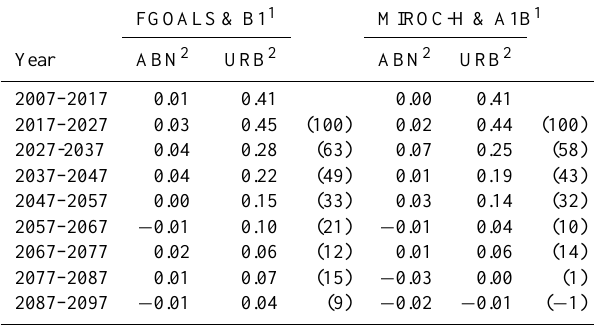
Table 2. Accounting of CO 2 removal from or emission to the at- mosphere due to soil organic carbon stock change evaluated with baseline method for a sequence of 10 periods with 10-years dura- tion in each from 2007 to 2097 under different future scenarios of climate and land-use change (unit: TgCO 2 yr − 1 ) . Numbers shown are differences in CO 2 removal from or emission to the atmosphere due to changes in size of soil organic carbon pool between BAU and MAFF-BP scenario (MAFF-BP minus BAU). Negative and positive value indicates relative CO 2 removal from or emission to the atmo- sphere due to changes in size of soil organic carbon pool in MAFF- BP scenario compared with those in BAU scenario. For land-use change scenario urbanization (URB), numbers in parenthesis indi- cate percentage values compared with the level in 2017–2027 that held the greatest removal of CO 2 in entire